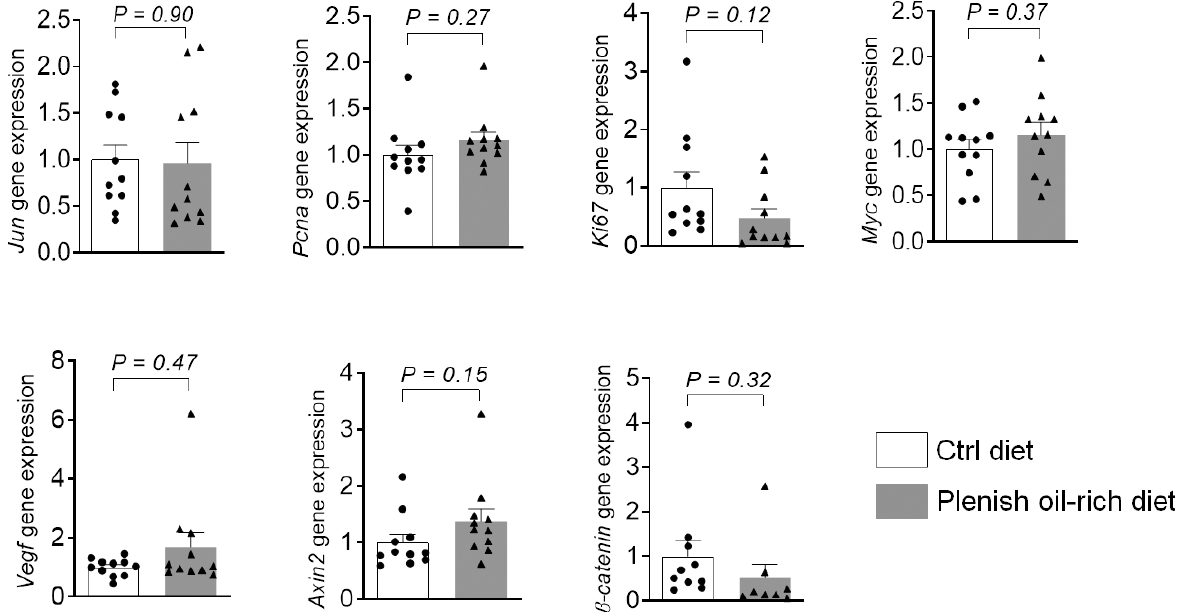
Figure 4. Effects of Plenish soybean oil on colonic expression of tumor markers. The results are expressed as mean ± SEM, n = 8–11 mice per group.